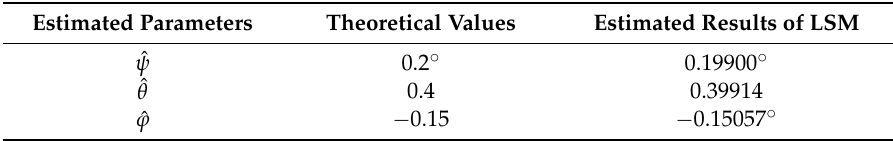
Table 4. Estimation results of the image-plane rotary-tilt